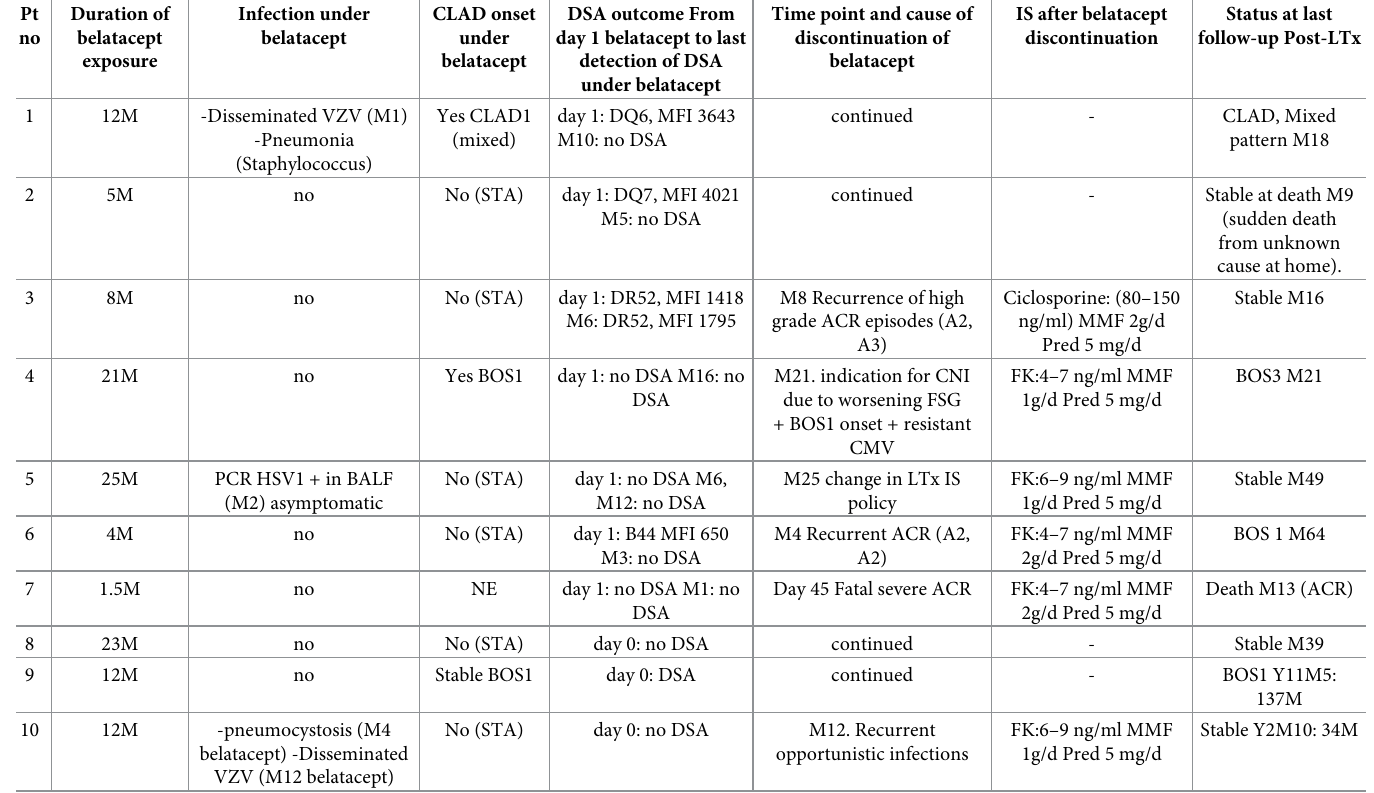
Table 3. Incidence of infections and chronic allograft rejection (CLAD) after starting belatacept.